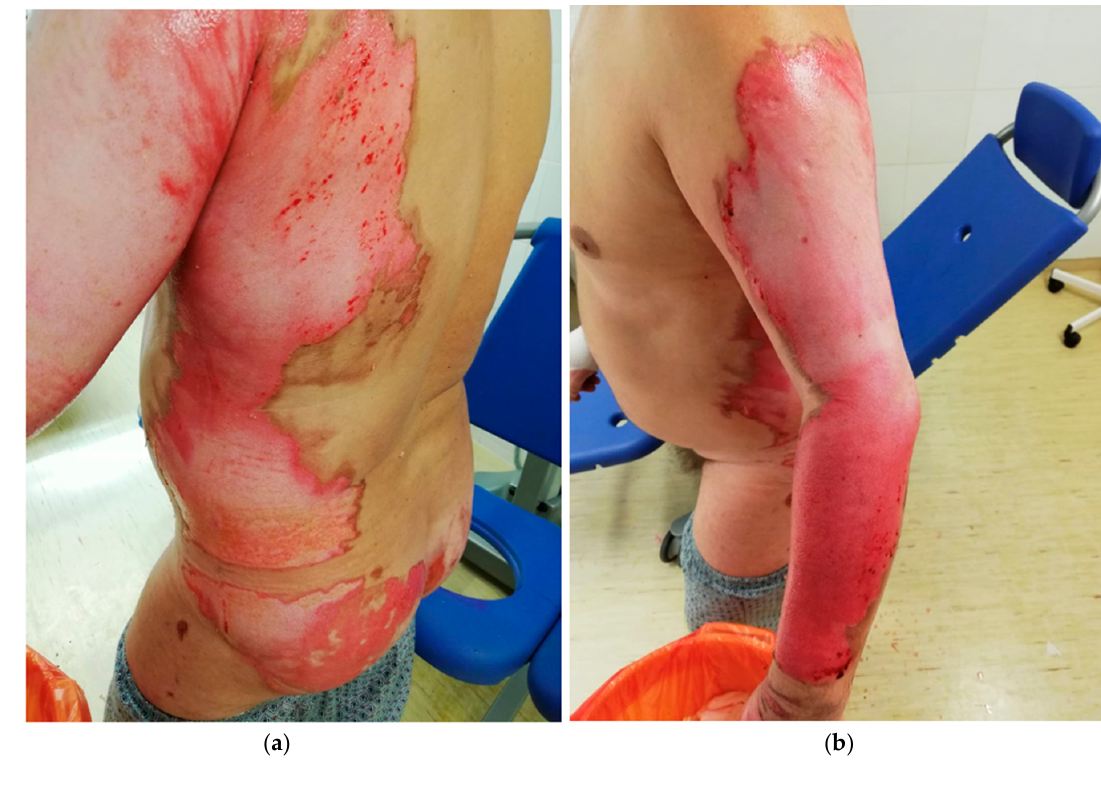
Figure 5. ( a , b ) 2nd degree burn.